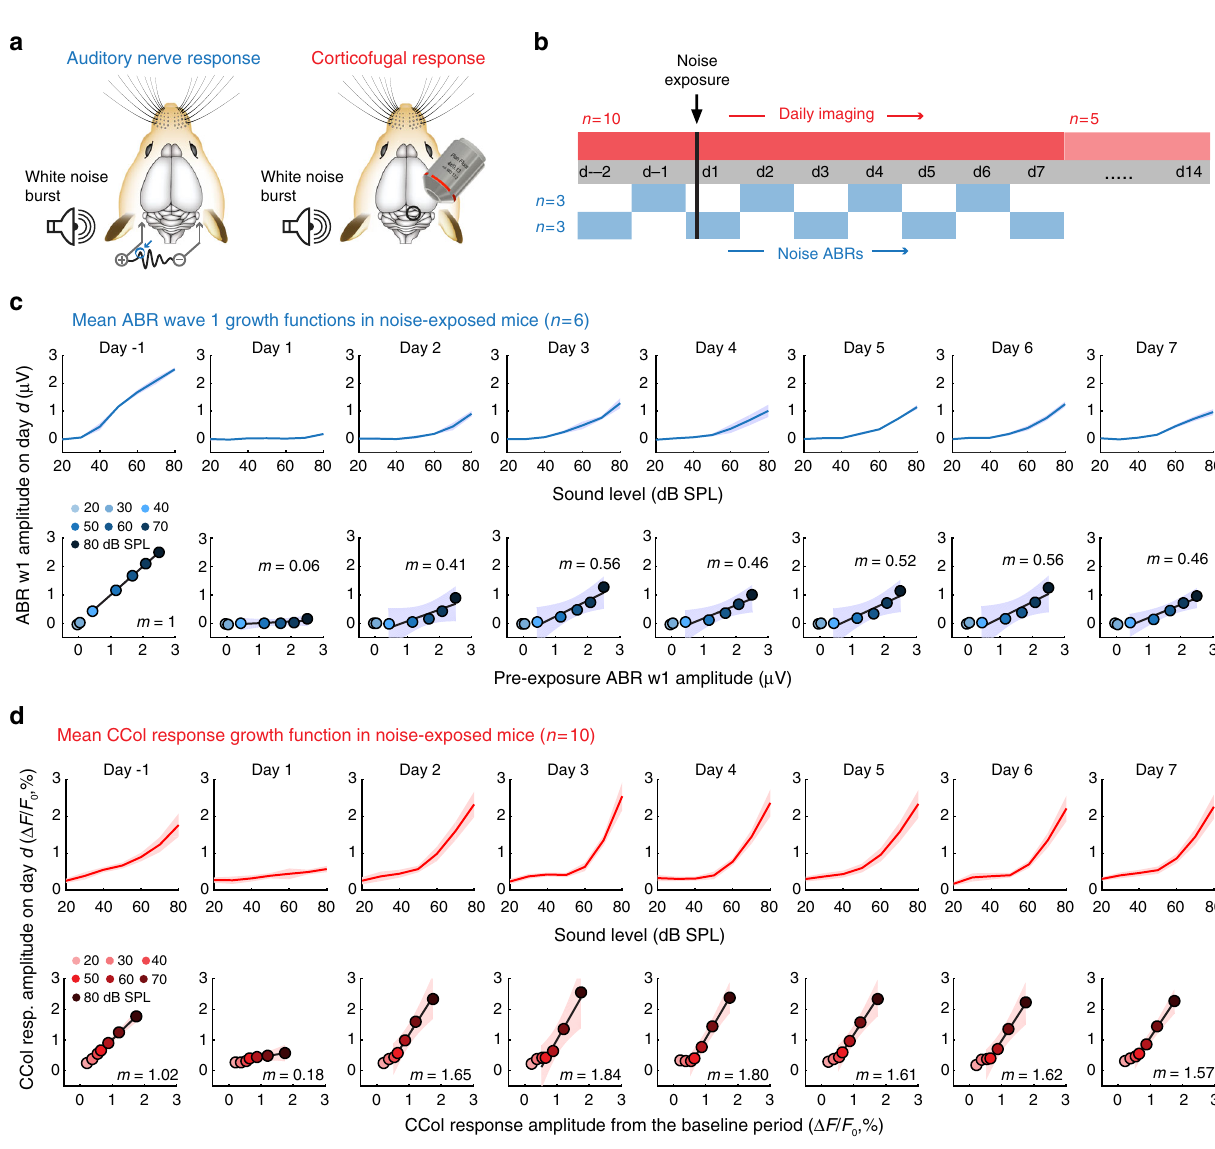
Fig. 4 Opposing changes in auditory nerve and corticocollicular response growth functions following cochlear synaptopathy. a Auditory nerve growth functions were measured under anesthesia every other day according to the change in ABR wave 1 (blue circle) amplitude to white noise bursts of varying level ( n = 6). CCol response growth functions were measured daily in a separate cohort of awake mice ( n = 10) also using white noise bursts, per previous fi gures. b ABR wave 1 and CCol responses were both measured for 2 days (d) prior to moderate noise exposure and for 7 days following noise exposure. In a subset of noise-exposed mice ( n = 5), CCol imaging was extended for an additional week after noise exposure. c , d As per Fig. 2e, ABR wave 1 ( c ) and CCol response ( d ) growth functions (top rows) and scatterplots of linear fi ts for baseline vs post-exposure growth functions (bottom rows) are provided for all mice. Data represent mean ± SEM. Linear fi ts of the fi ve highest sound levels are illustrated by the solid black line with corresponding slope ( m ) and 95% con fi dence interval (blue and red imaging session × sound level interaction term, F > 7, p < 0.05, n = 10, Fig. 4d).